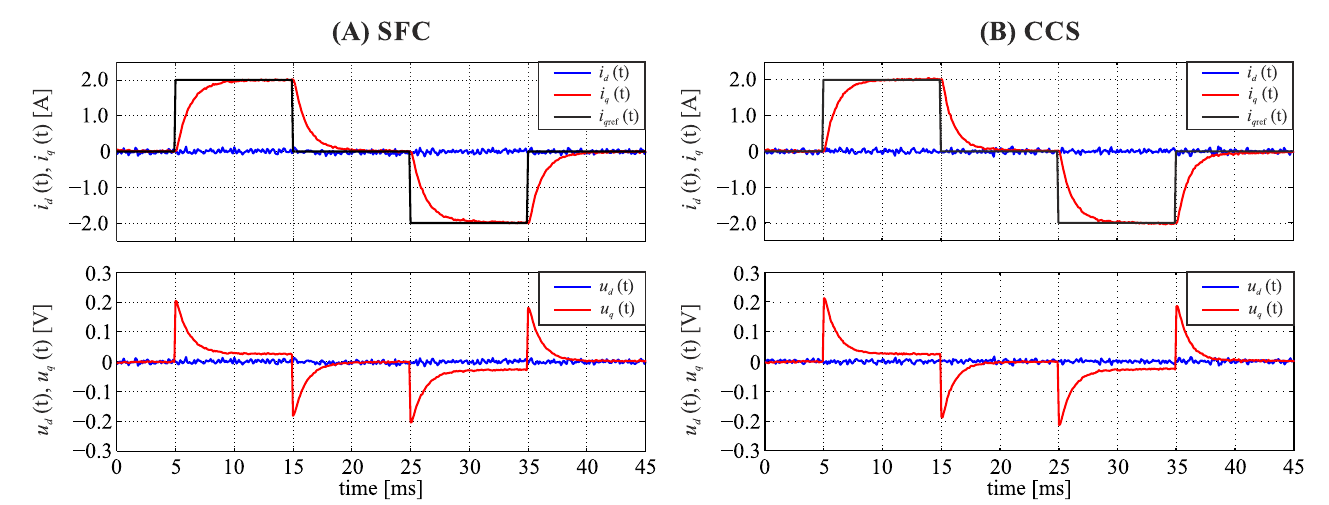
Figure 6. Current step response for investigated control structures: ( A ) state feedback controller, ( B ) PI based cascade control